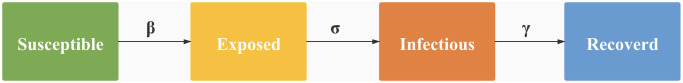
SEIR model with 4 states.